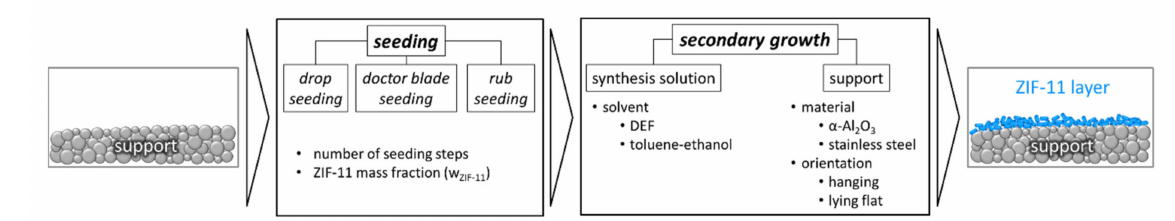
Figure 10. Overview on the variations performed for seeding and secondary growth of ZIF-11 layers.